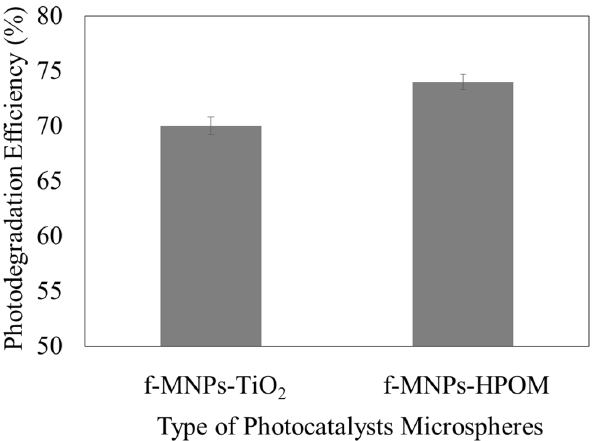
Membranes 2023 , 13 , x FOR PEER REVIEW Figure 4. Photodegradation efficiency of f-MNPs-TiO 2 and f-MNPs-HPOM microspheres. Figure 4. Photodegradation efficiency of f ‐ MNPs ‐ TiO 2 and f ‐ MNPs ‐ HPOM microspheres.